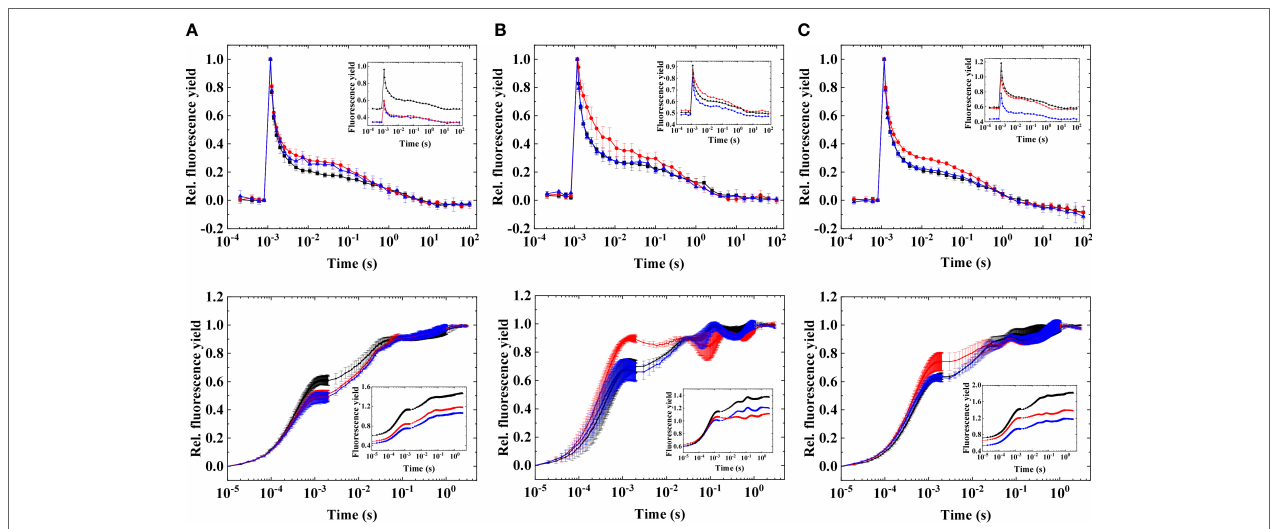
FIGURE 1 | Flash-induced fluorescence relaxation (upper panel) and OJIP induction curves (lower panel) in three different strains of Symbiodiniaceae under elevated temperatures. (A) Fugacium kawagutii (CS156), (B) Symbiodinium tridacnidorum (2465), and (C) Symbiodinium microadriaticum (2467), including control (black), 34°C 2 h (red), and recovery (blue). Main figures: normalized fluorescence traces [mean values of three biological replicates ± standard deviation (S.D.)]. Insets: original data (representative traces). The fluorescence traces were double normalized (F 0 to 0 and F m to 1) to achieve the same initial amplitudes. Insets show original traces without normalization.